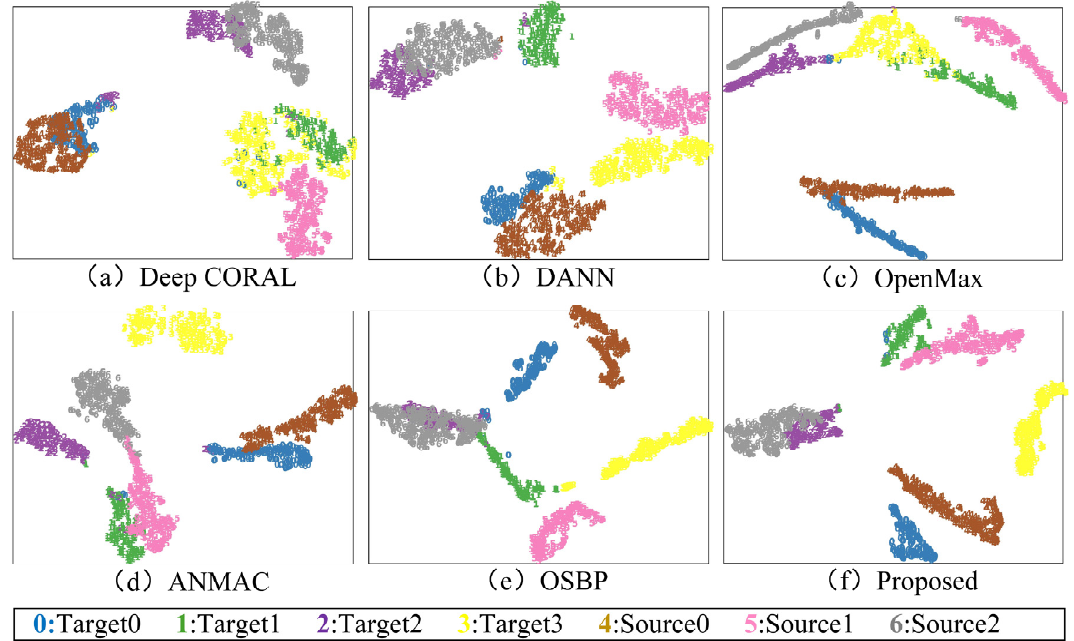
Figure 7. Feature visualization for transfer task a1. ( a ) Deep CORAL, ( b ) DANN, ( c ) OpenMax, ( d ) ANMAC, ( e ) OSBP, ( f ) Proposed.